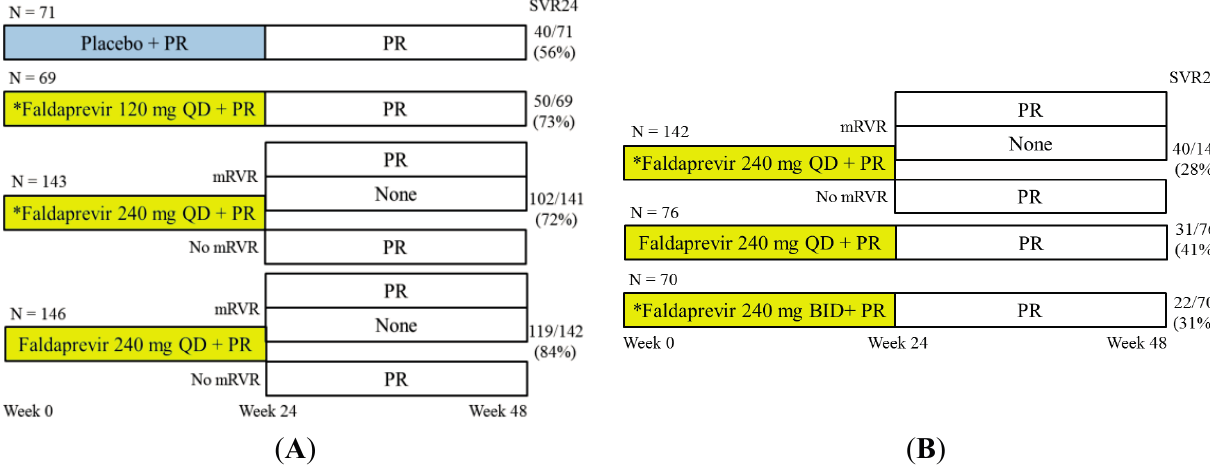
Figure 2. Safety, and antIviraL Effect of faldaprevir iN hepatitis C (SILEN) trial designs